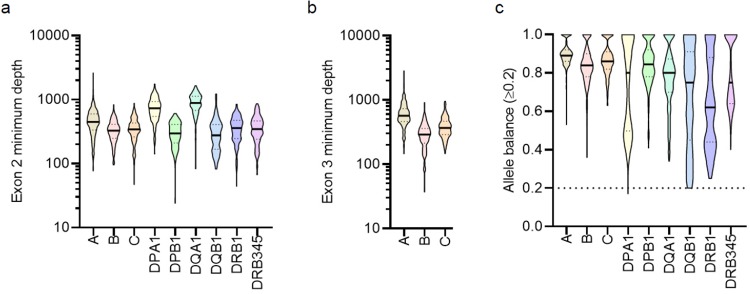
Distributions of minimum coverage depths in key exons and allele balance.a) Minimum coverage depth for exon 2 of all loci. b) Minimum coverage depth for exon 3 of class I loci. c) Allele balance. Values from 218 samples are plotted. For samples that underwent repeat testing, the values from the repeat testing (not the initial run) were included in the plots. Line and dotted lines in the violin plots represent median and interquartile range (IQR), respectively.